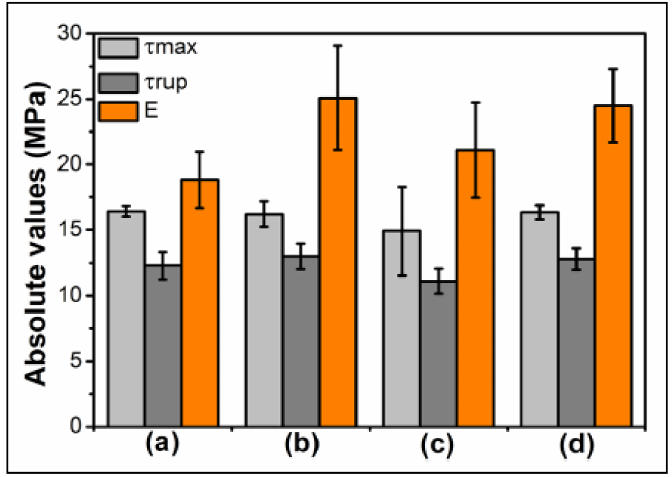
Figure 32. Mechanical test results of polymer composites: ( a ) neat polyethylene, ( b ) PE-commercial